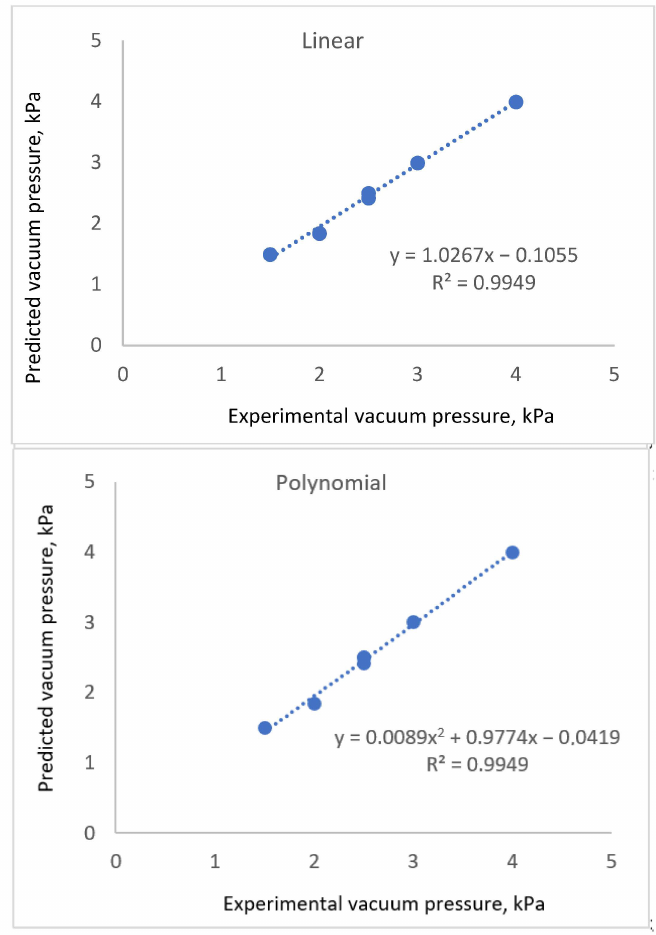
Figure 3. Polynomial and linear regression